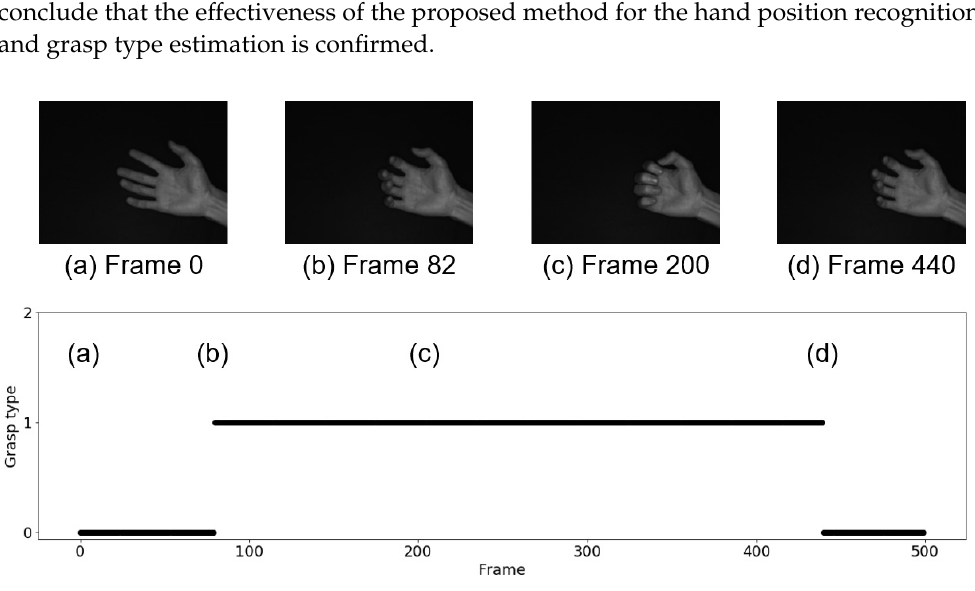
Figure 10. Estimation result in case of power grasp.